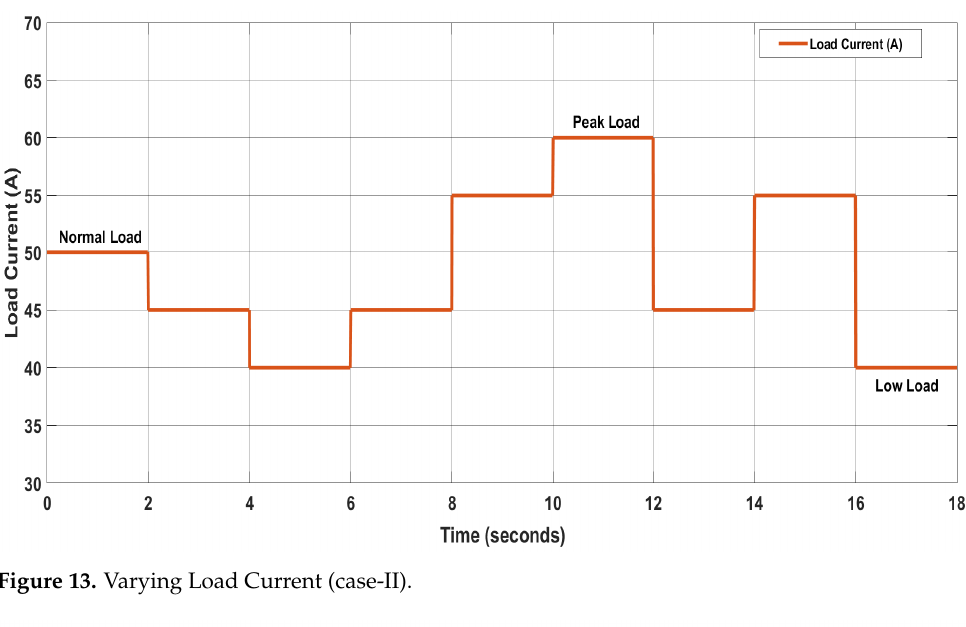
Figure 12. ( a ) Case:I SoC of Battery ( b ) Case:I SoC of UC.